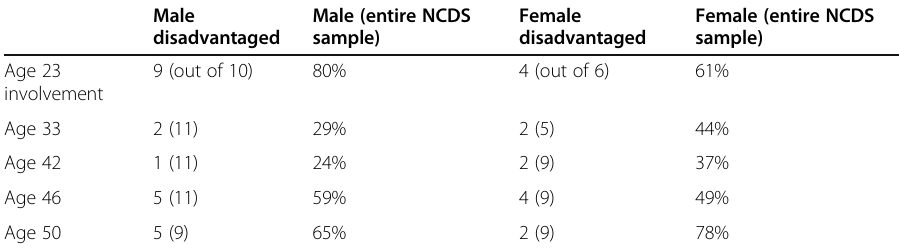
Table 3 Institutional involvement of NCDS panel members Male